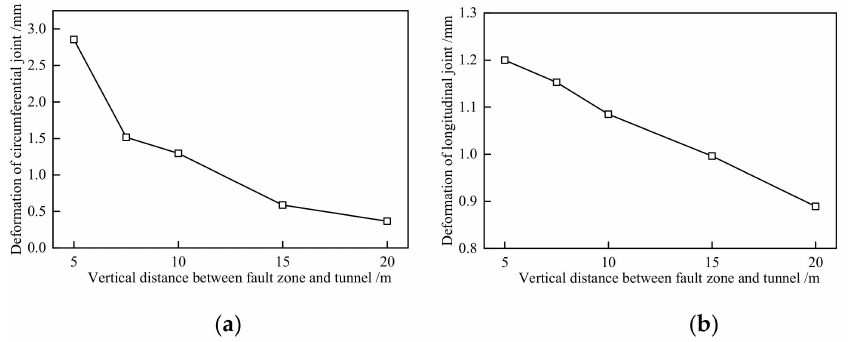
Figure 22. Effect of the vertical distance h on the segmental joints deformation: ( a ) normal faulting condition and ( b ) reverse faulting